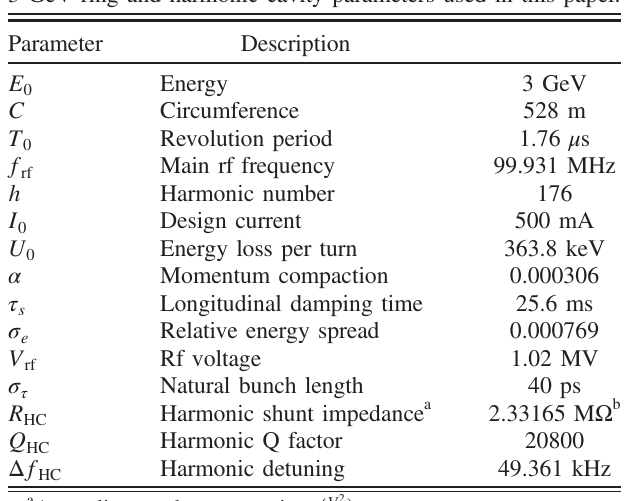
TABLE I. Nominal bare lattice parameters of the MAX IV 3 GeV ring and harmonic cavity parameters used in this paper.